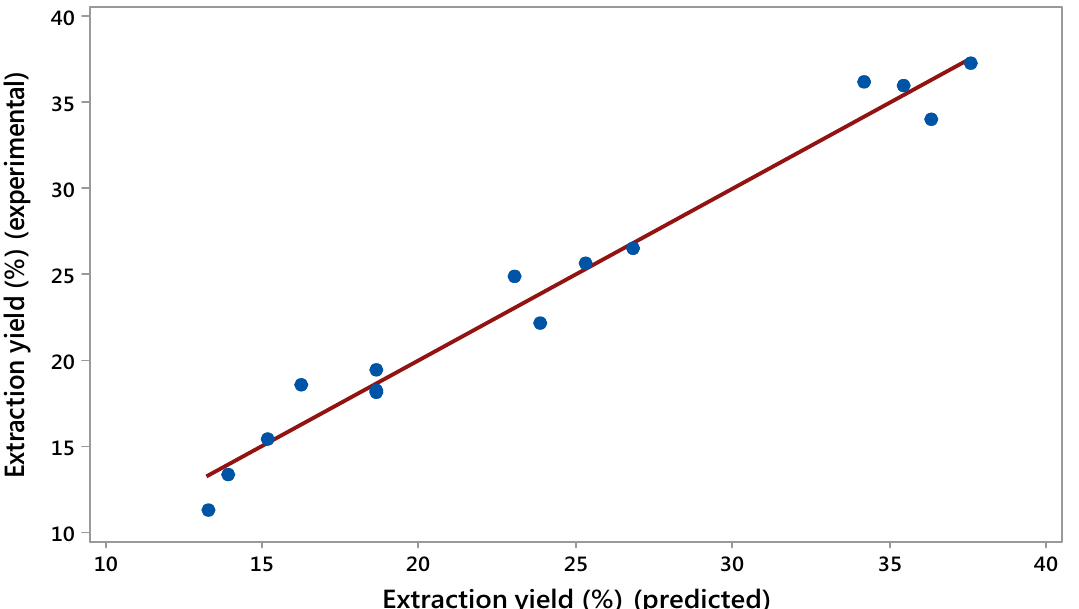
Fig. 4 Plot of difference showing the variation in the extraction yield obtained experimentally and the predicted values through the RSM technique Table 10 Variation in experimental and the predicted values Run.